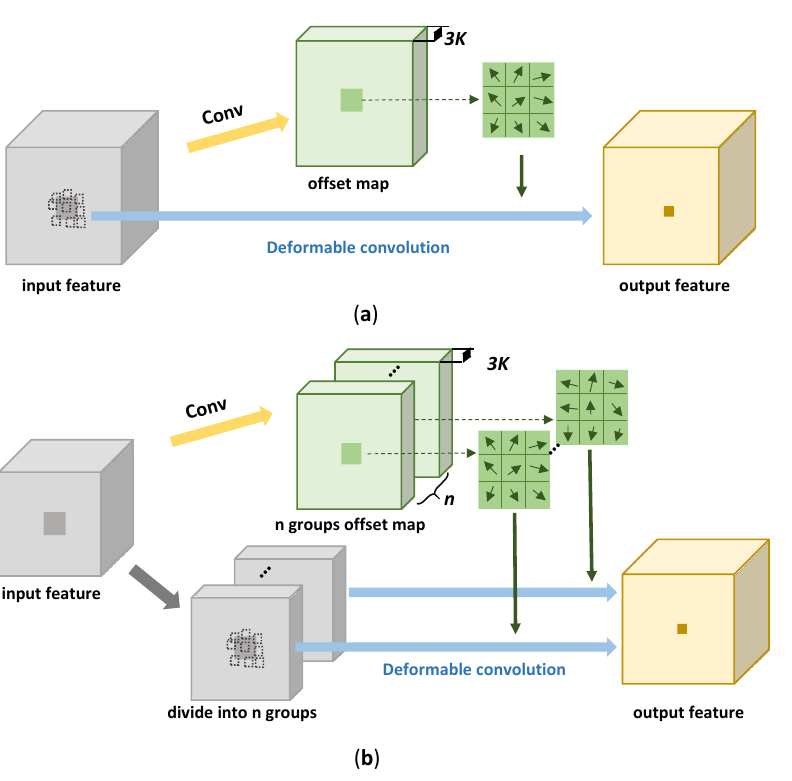
Figure 7. Illustration of 3 × 3 deformable convolution: ( a ) One deformable group; and ( b ) n deformable